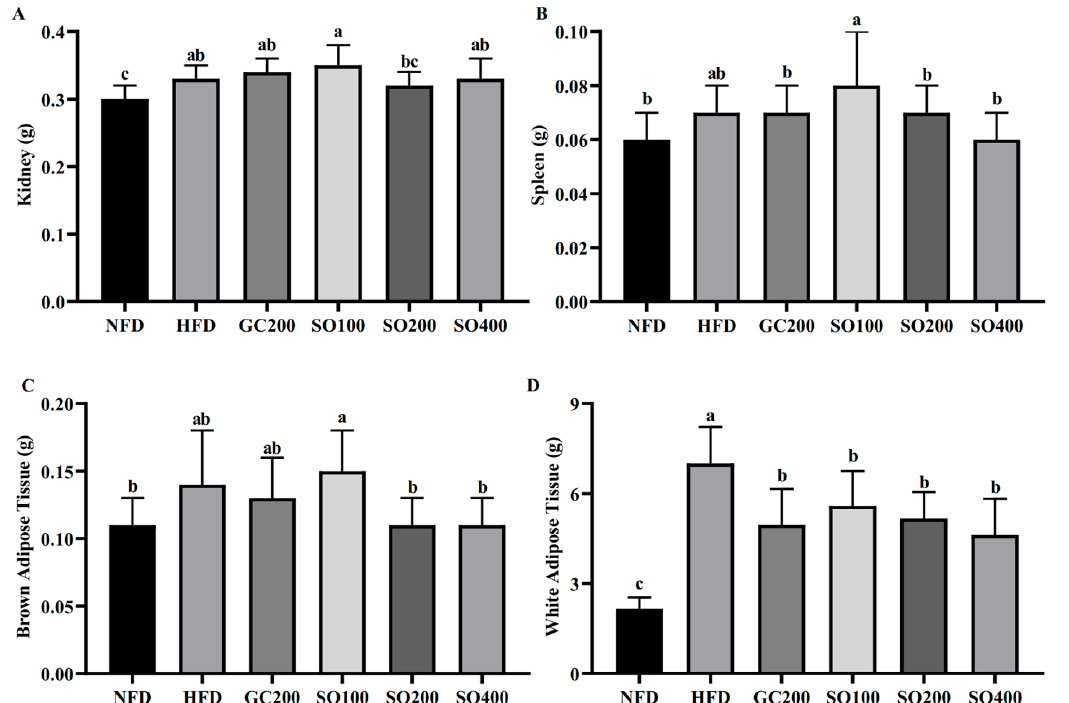
Figure 5. Effect of SO on organ weights in HFD-induced obese mice: ( A ) kidney weight; ( B ) spleen weight; ( C ) brown adipose tissue weight; and ( D ) white adipose tissue weight (visceral, epididymal, perirenal, retroperitoneal, and subcutaneous fat). GC200, HFD supplemented with 200 mg/kg/day of GC; SO100, HFD supplemented with 100 mg/kg/day of SO; SO200, HFD supplemented with 200 mg/kg/day of SO; SO400, HFD supplemented with 400 mg/kg/day of SO. Values are expressed as mean ± SD of experiments. Different letters indicate significant differences at the level of p <